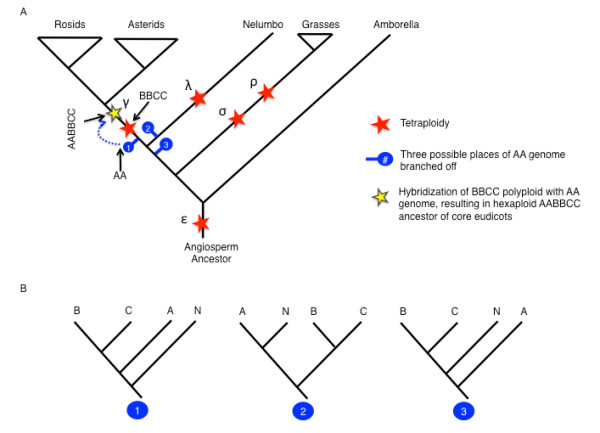
Polyploidy events in the history of angiosperm evolution. (A) Summary of polyploidy events in the history of angiosperm evolution, with a focus on the possible phylogenetic origins of the three subgenomes comprising the gamma paleohexaploidy event in core eudicots. Synteny analysis of the Nelumbo genome indicates that gamma is shared only within the core eudicots; however, phylogenomic analysis suggests a more complex history since around half of the gamma pairs were duplicated core-eudicot-wide and the other half eudicot-wide (See Table S10 in Additional file 1). AA, BB, and CC are three subgenomes of the ancestral hexaploidy. Three possible phylogenetic origins of the ancestral AA genome involved in gamma are denoted by 1, 2 and 3. Lamda is defined as the most recent polyploidy event in the evolutionary history of Nelumbo. All the other Greek symbols are well-known polyploidy events in the evolutionary history of angiosperms. Gamma: genome-triplication (hexaploid) event in core eudicot genomes [7,23]; Sigma and rho: genome duplications detected in grass genomes [8]; Epsilon: angiosperm-wide duplication detected in large-scale gene family phylogenies. Based on gene tree phylogenomics, we hypothesize that the triplication event involved a tetraploid event (BBCC red star) first, then subgenome AA combined with BBCC to form hexaploidy AABBCC (blue dashed line). (B) Predicted gene tree topologies of hypothetical origins of the AA subgenome of the gamma paleohexaploidy. A, B, C indicate surviving genes inherited from AA, BB, CC subgenomes of the AABBCC ancestral hexaploidy. N indicates genes of Nelumbo.